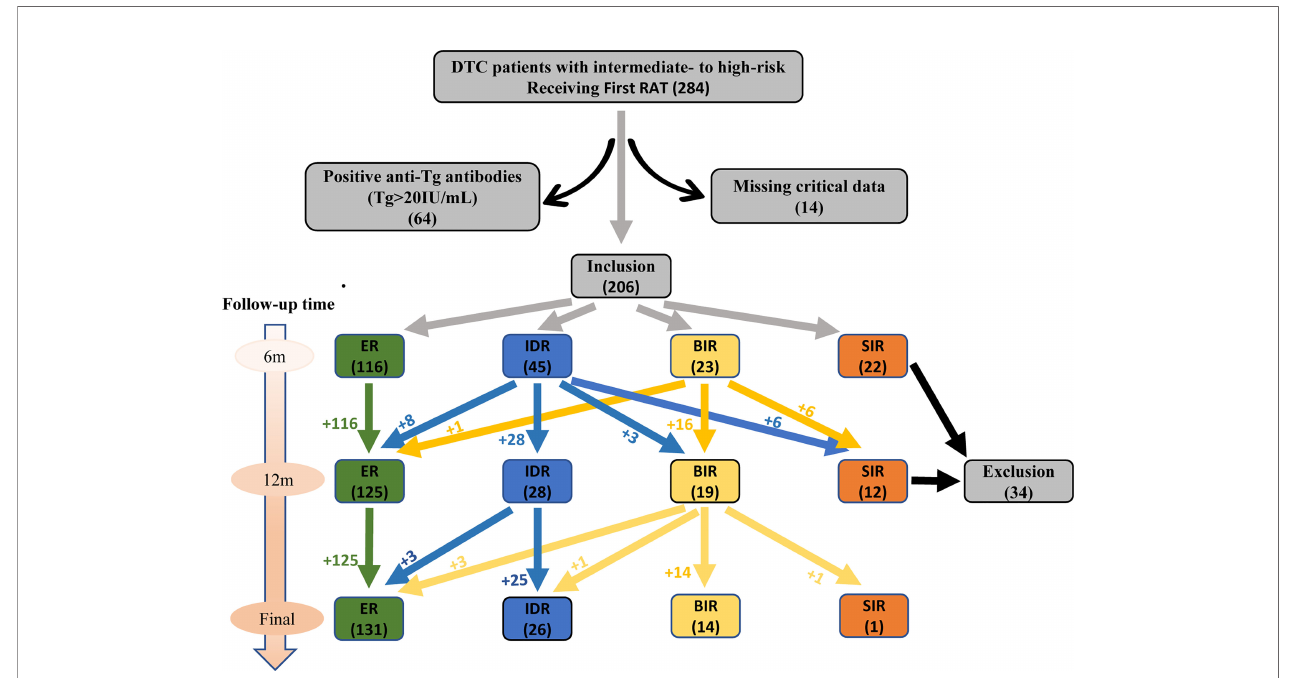
FIGURE 1 | Flow chart for selection process of eligible